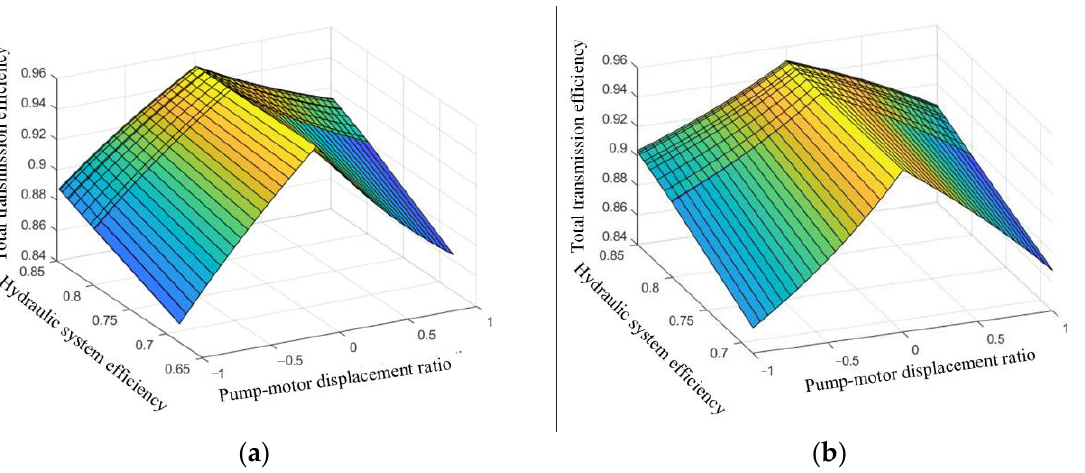
Figure 10. The efficiency of the hydro-mechanical stage: ( a ) Efficiency graph of HM1 (HM3) and ( b ) efficiency graph of HM2 (HM4). efficiency graph of HM2